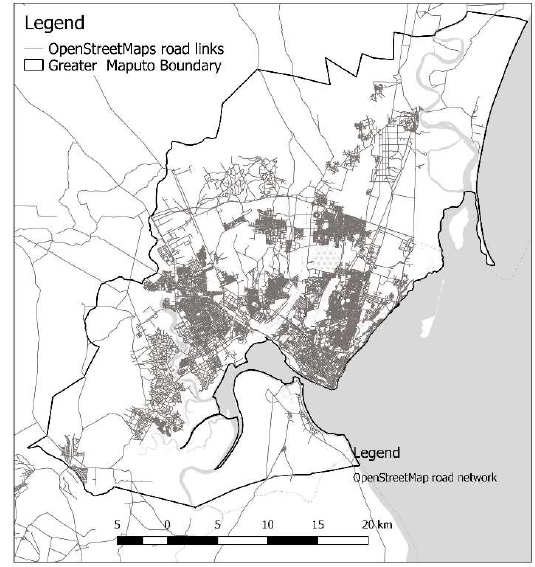
Figure 4. Image of the available OpenStreetMap road links in Greater Maputo.